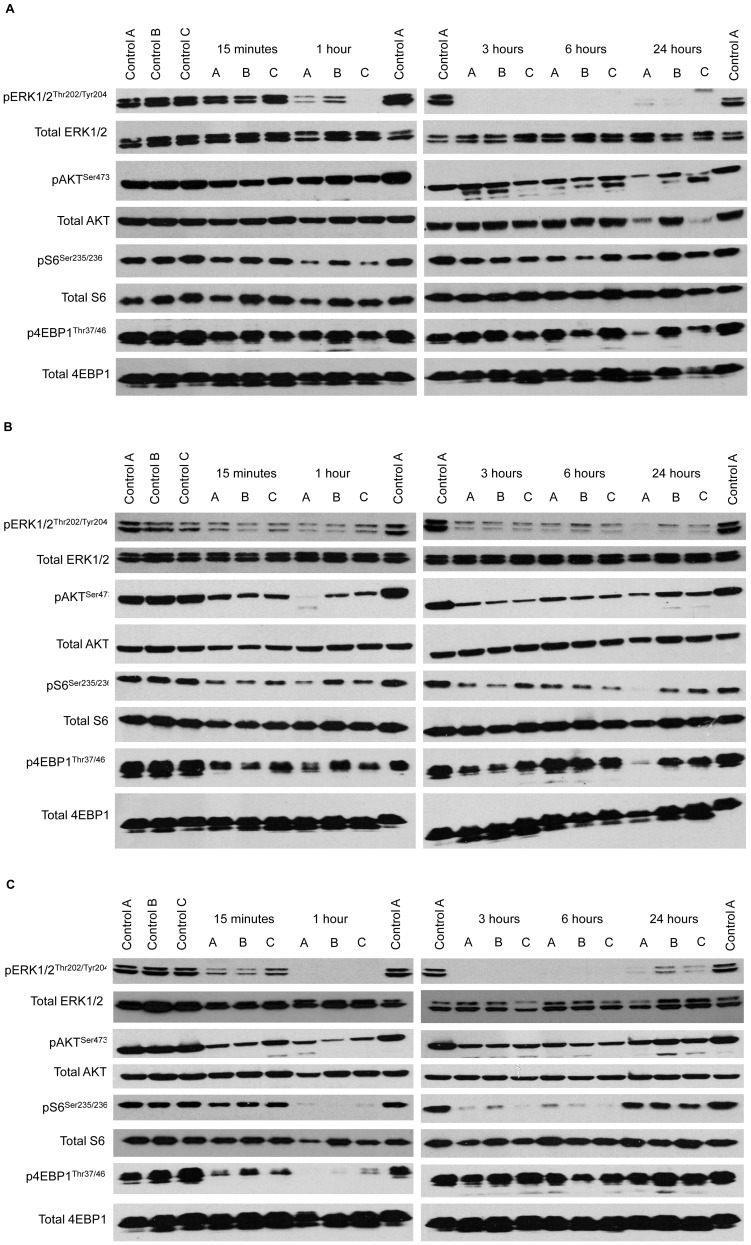
Pharmacodynamic analysis of the in vivo effect of PD 0325901 and GDC-0941 on signal transduction.Effects on the MAPK and PI3K/AKT signal transduction pathways after HCT116 tumour xenograft-bearing mice were treated with a single p.o. dose of either 1 mg/kg of the MEK inhibitor PD 0325901 alone (A), 100 mg/kg of the PI3K inhibitor GDC-0941 alone (B) or the combination of 1 mg/kg of the MEK inhibitor PD 0325901 and 100 mg/kg of the PI3K inhibitor GDC-0941 (C). After 0.25–24 hours, tumours were removed and lysates subjected to electrophoresis, followed by Western blotting using the indicated phospho-specific antibody. Blots were then stripped and re-probed with the corresponding total protein antibody to confirm equal protein loading. A–C represents samples from the three mice in each treatment group.